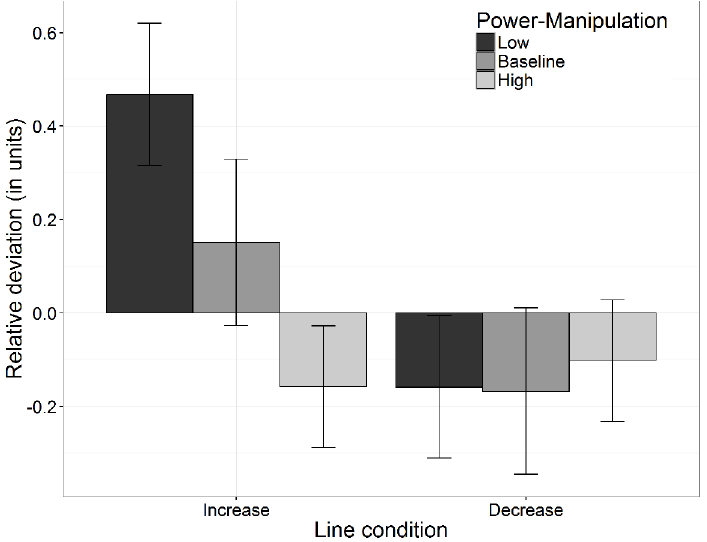
Figure 2. Relative deviations of line length estimations of participants in the low-power, baseline, and high-power condition, separately for the increase and decrease condition. Error bars indicate standard